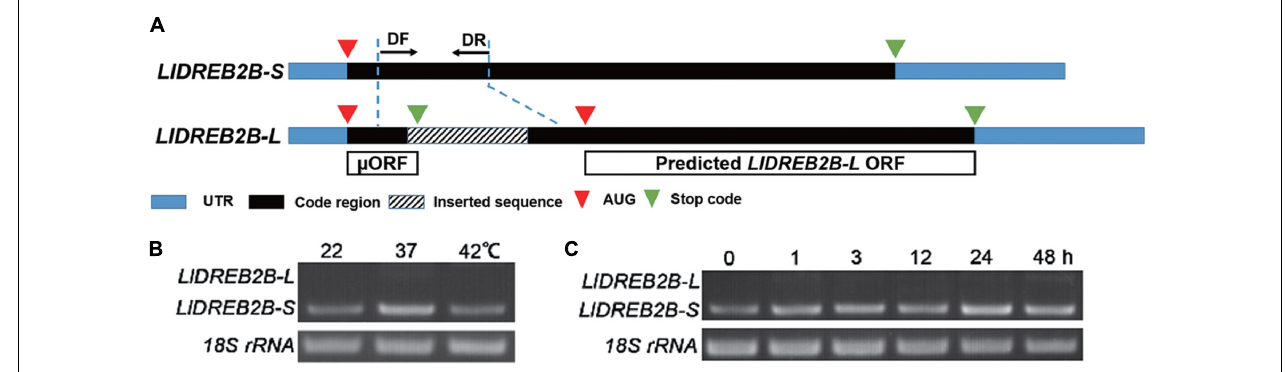
FIGURE 1 | Isolation and identification of LIDREB2B from lily. (A) Schematic diagram indicating the two variants of LIDREB2B. LIDREB2B-L has the same nucleotide sequence as LIDREB2B-S except for a 198-bp sequence insertion in the codon region, which causes a frame shift and premature termination to generate a short ORF ( µ ORF). (B) RT-PCR assay of transcript accumulations of LIDREB2B-L and LIDREB2B-S under different temperature treatments. Leaf samples of ‘White heaven’ were treated at 37 or 42 ◦ C for 3 h. Primers (DF and DR) were designed to amplify the two variants in one reaction as indicated in A . (C) RT-PCR assay of transcript accumulations of LIDREB2B-L and LIDREB2B-S under HS treatments of different lengths. Leaf samples of ‘White heaven’ were treated with HS at 37 ◦ C for 0, 1, 3, 12, 24, or 48 h. Primers were the same as in B . Bands in B,C were confirmed by sequencing. Three independent experiments were performed, and one representative is shown.